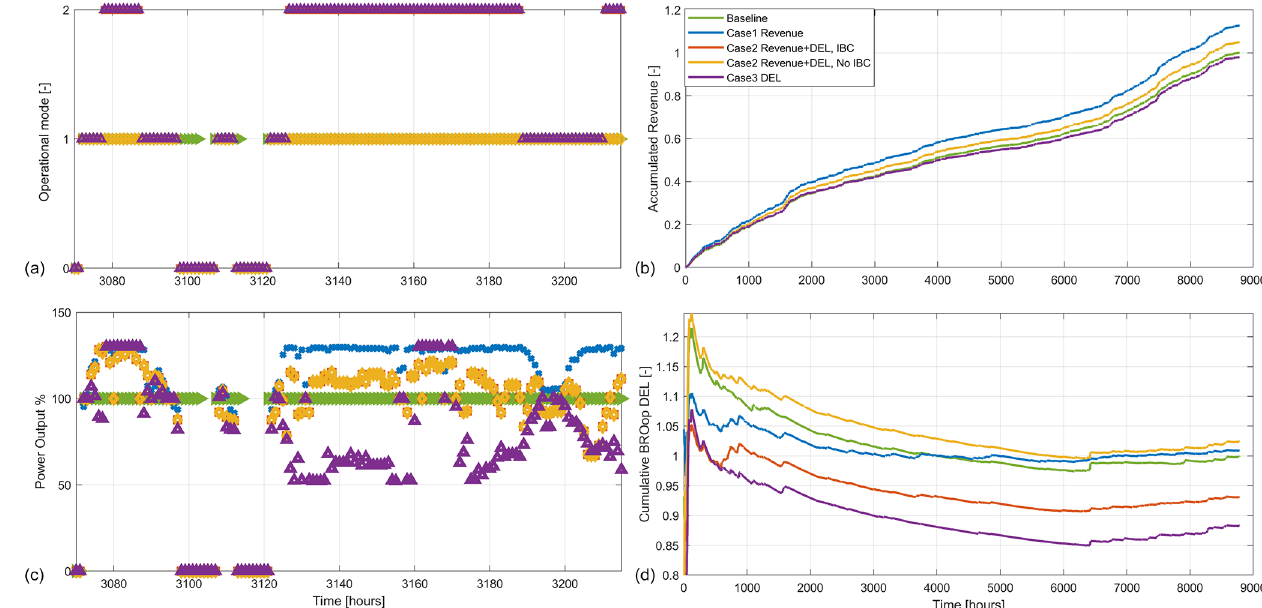
Figure 3. Example time series of instantaneous values for a subset of 2030 (a, c) and cumulative values for the whole 1-year time series of 2030 (b, d) . (a) Activation of individual blade pitch control (IBC) for controller modes and operational status (0: turbine shut down; 1: IBC inactive; 2: IBC activated). (c) Percentage of the instantaneous power output where 100% corresponds to the nominal power curve. (b) Accumulated revenue over time for different operational strategies. Normalised with the final accumulated value of the baseline where the turbine is operated constantly at 10MW without IBC. (d) Cumulative damage equivalent load (DEL) of blade root out-of-plane moment (BROop) for the same cases, normalised with the final cumulative value of the baseline where the turbine is operated constantly at 10MW without IBC.